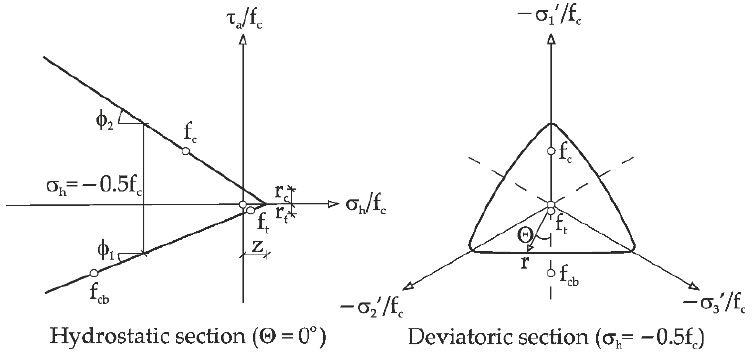
Figure 4. Three parameter model [40].